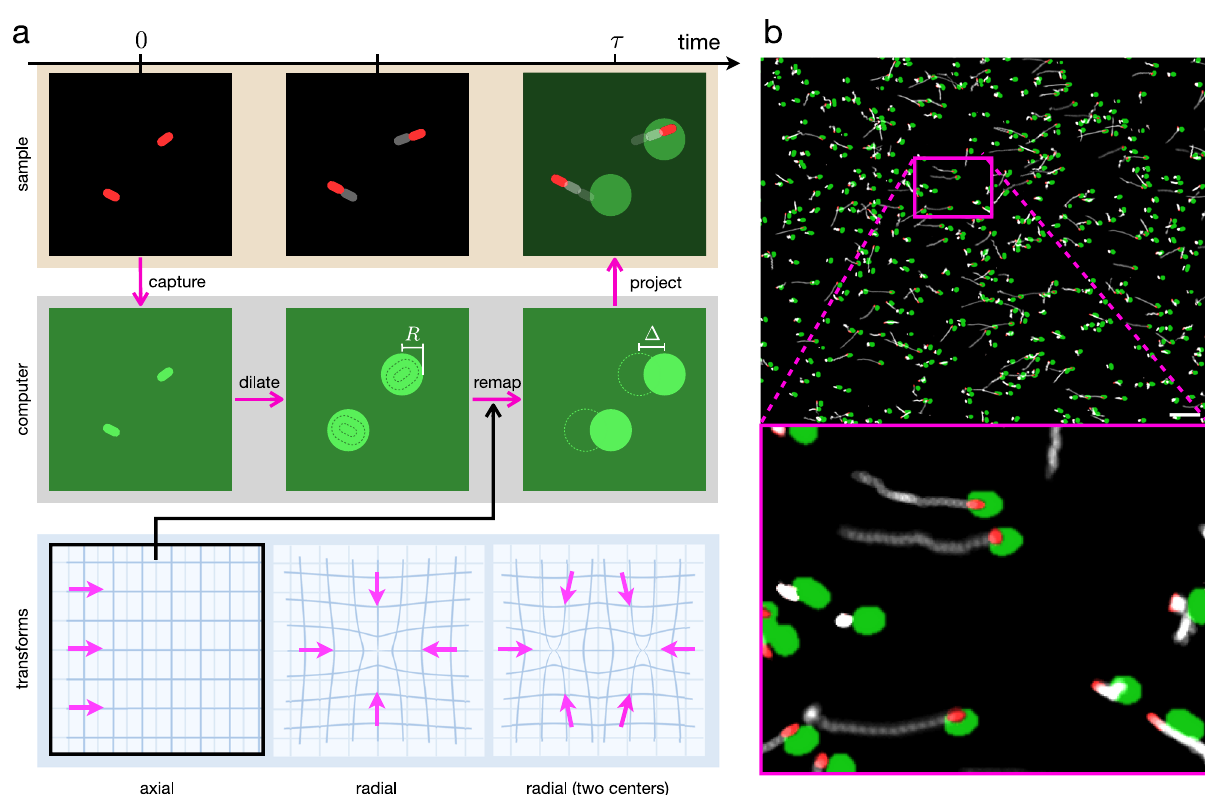
Fig. 1 Optical feedback loop. a Schematic representation of the feedback loop and image transformations. Red spots represent bacteria while light intensities are shown in green. First we capture a system's snapshot in dark fi eld mode. Secondly we dilate the image using a circular kernel so that every cell is replaced by an approximately circular object of radius R . Then we remap this image by a plane transformation that moves the content of every pixel by a distance Δ towards the desired fl ow direction ^ n . In our experiments we considered axial and radial (one or two centers) transformations. Finally we project the transformed image back onto the system after a delay time τ . b Experiment in which cells are guided towards the right. Dark- fi eld microscope image of the bacteria (red) superimposed with the bright ( I 1 ) regions in projected light pattern (green) with R = 3.8 μ m, Δ = 5.1 μ m and τ = 0.2 s. Bottom image is an enlargement of the box shown in the top. White traces represent bacterial trajectories and are obtained by superimposing images acquired in the previous 2 s. Scale bar is 40 μ m. See Supplementary Movie